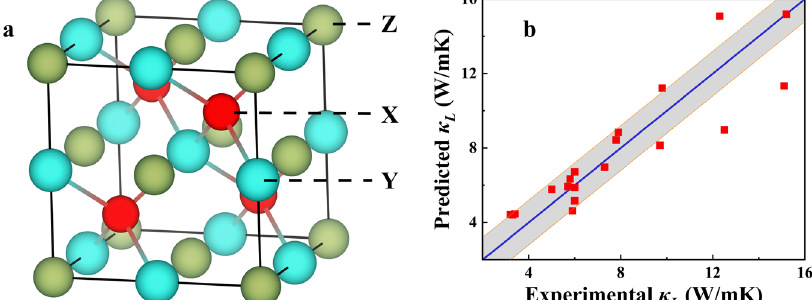
Fig. 4 Generalization to half-Heusler compounds. a The crystal structure of half-Heusler compounds and the three atomic sites (X, Y, Z) are marked. b The intuitive linear correlation between the predicted and experimental k L of several alloyed half-Heusler compounds, where the shaded area indicates the range of the mean absolute